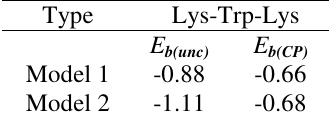
(eV) and counterpoise corrected binding b(unc)